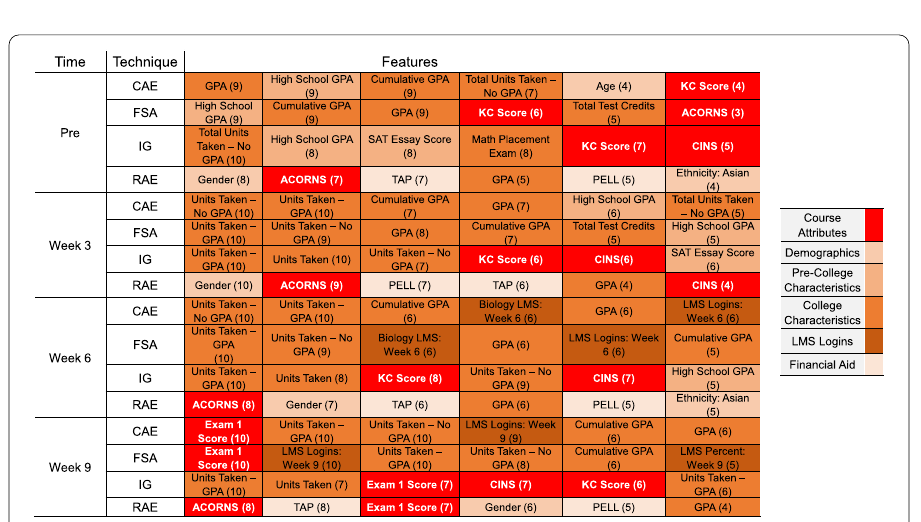
Fig. 7 Mean Jaccard index correlation matrix for each time frame and preprocessing feature selection technique